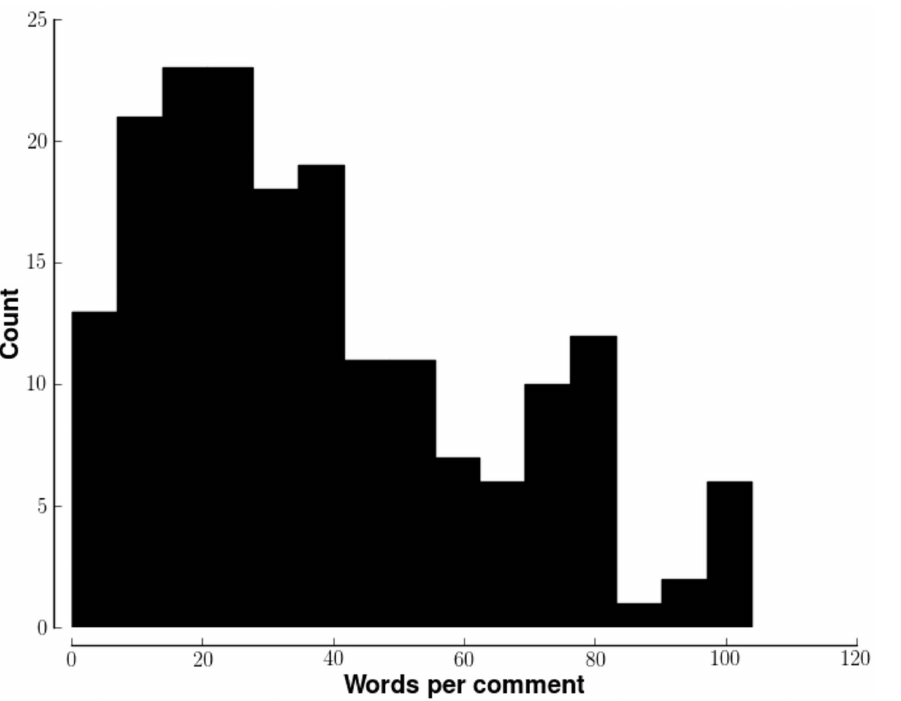
Figure 1. Number of words in YouTube comments. The histogram (bin size ~ 9 YouTube comments analyzed in this paper. Words were defined as strings of characters flanked by white spaces after the preprocessing described in results. The bin size for the histogram is 9 words.